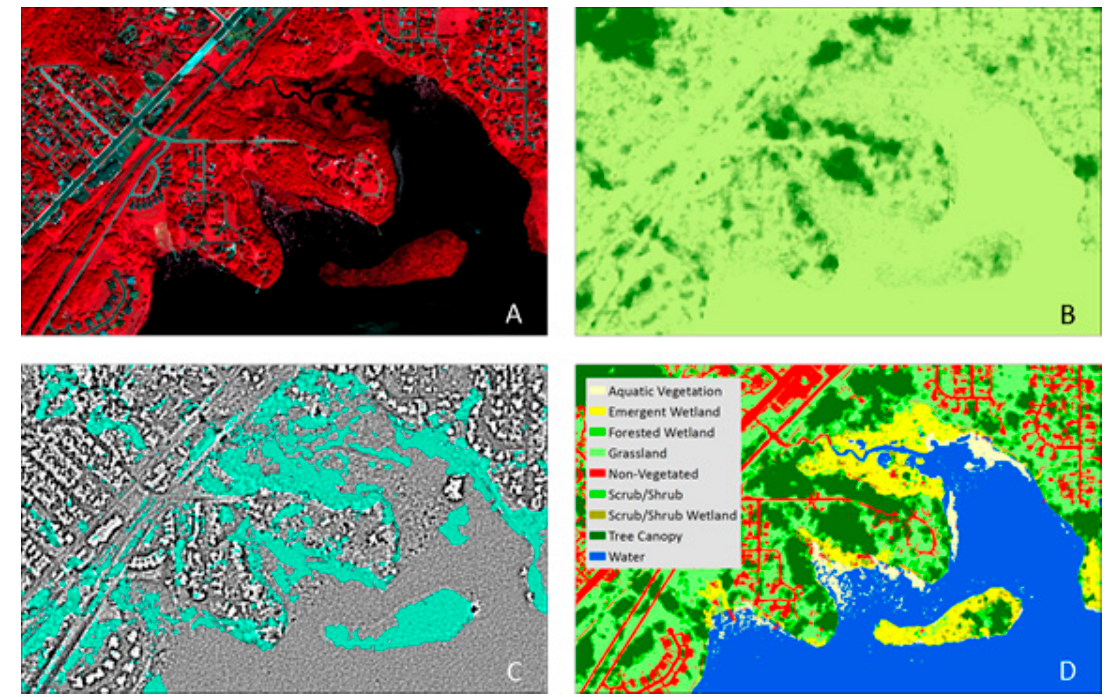
Figure 7. The resulting land cover classification from integrating WorldView3 data from DigitalGlobe ( A ), stereo-derived nDSM from SharedGeo ( B ), wetland classification from MTRI (in cyan) overlaid stereo-derived TPI ( C ), and the resulting land cover classification including emergent, scrub/shrub, and forested wetlands ( D ).